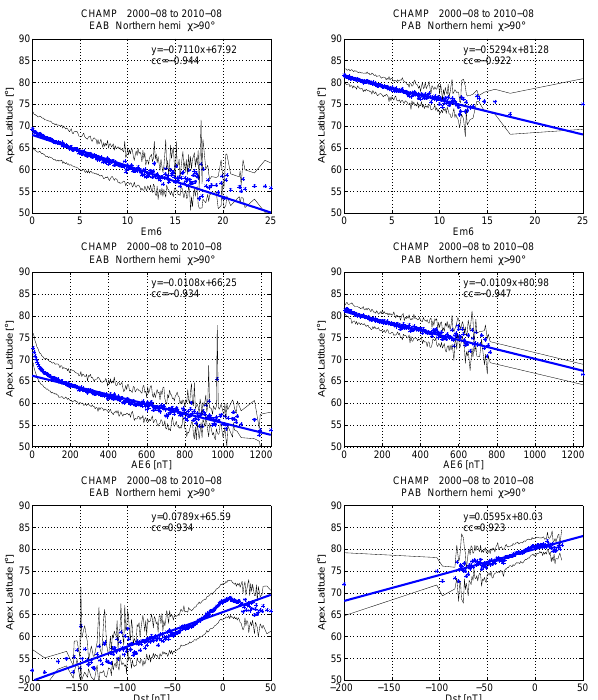
Figure 8. The dependence of the auroral boundary latitude on merg- Fig. 8. The dependence of the auroral boundary latitude on merging electric field (top), auroral electrojet index ing electric field (top), auroral electrojet index (middle), and Dst in- (middle), and Dst index (bottom). For the equatorward boundary (left) all local times from 0000 to 2400 MLT dex (bottom). For the equatorward boundary (left) all local times areconsidered, whileforthepolewardboundary(right)onlydetectionsfromthetimesector0800to1600MLT from 00:00 to 24:00MLT are considered, while for the poleward have been used. The blue asterisks are the mean values of activity bins and the black lines denote the standard boundary (right) only detections from the time sector 08:00 to deviation of the bin values. 16:00MLT have been used. The blue asterisks are the mean values of activity bins, and the black lines denote the standard deviation of the bin